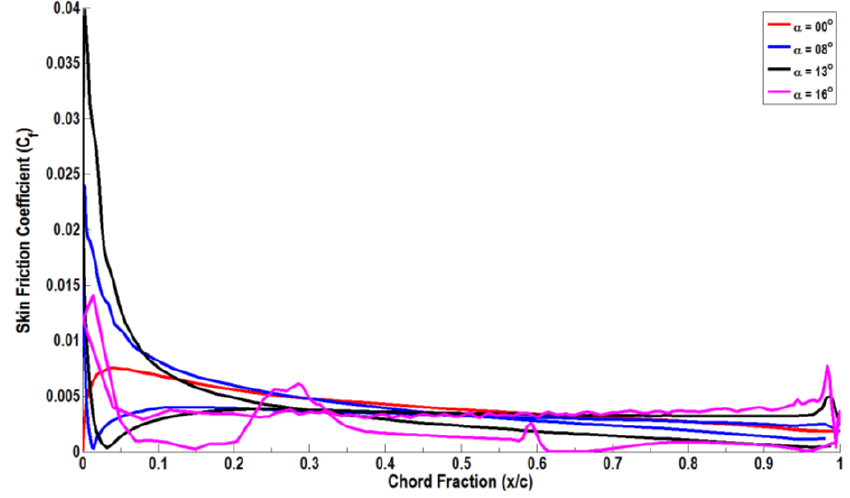
Figure 9. Skin friction coefficient curves along the airfoil with 0° flap deflection for different incidence angles at Re = 10 6 .